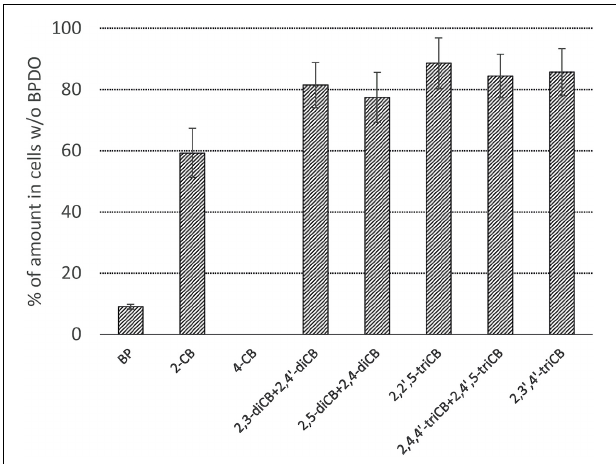
FIGURE 4 | Depletion of PCBs by E. coli cells expressing BPDO_AVS. Only congeners with a statistically significant depletion are shown ( p value < 0.05). The depletion rates were determined after the resting cell assay using IPTG-induced cells bearing both pQE31-bphAE_AVS and pYH31-bphFGBC_LB400 incubated with 0.0006% (w/v) Delor 103 for 24 h. The depletion rate of individual congeners is shown as the % of their amount in control microcosms bearing cells lacking BPDO_AVS. Error bars represent standard deviation ( n =